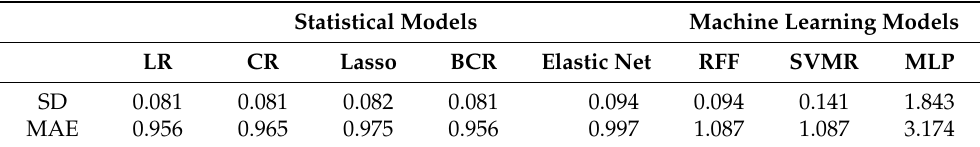
Table 5. Comparative last lane table of different learning methods results (speed) used. The error metric is the mean absolute error and is expressed in